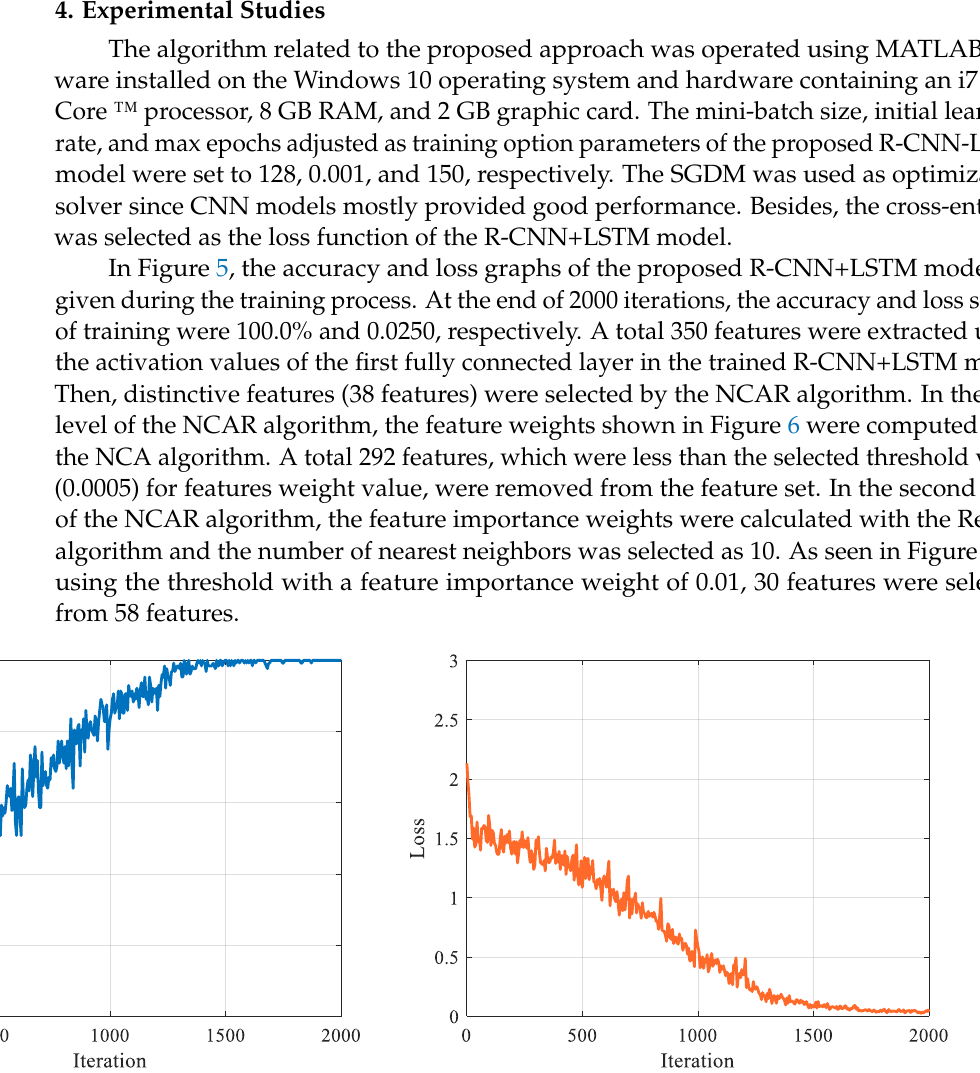
Figure 7. Training accuracy and loss graphs of the R-CNN+LSTM model. According to all classes and the levels of the NCAR feature selection algorithm, 3D representations of features sets are given for a sample in Figure 8. In Figure 8, the first, second, and third columns show the features without feature selection operation, the fea- tures selected with the first level of the NCAR algorithm, and the features selected with the second level of the NCAR algorithm, respectively. As seen in Figure 8, the features in the feature set obtained by the NCAR algorithm are morphologically better differentiated from the raw deep features (350 features).